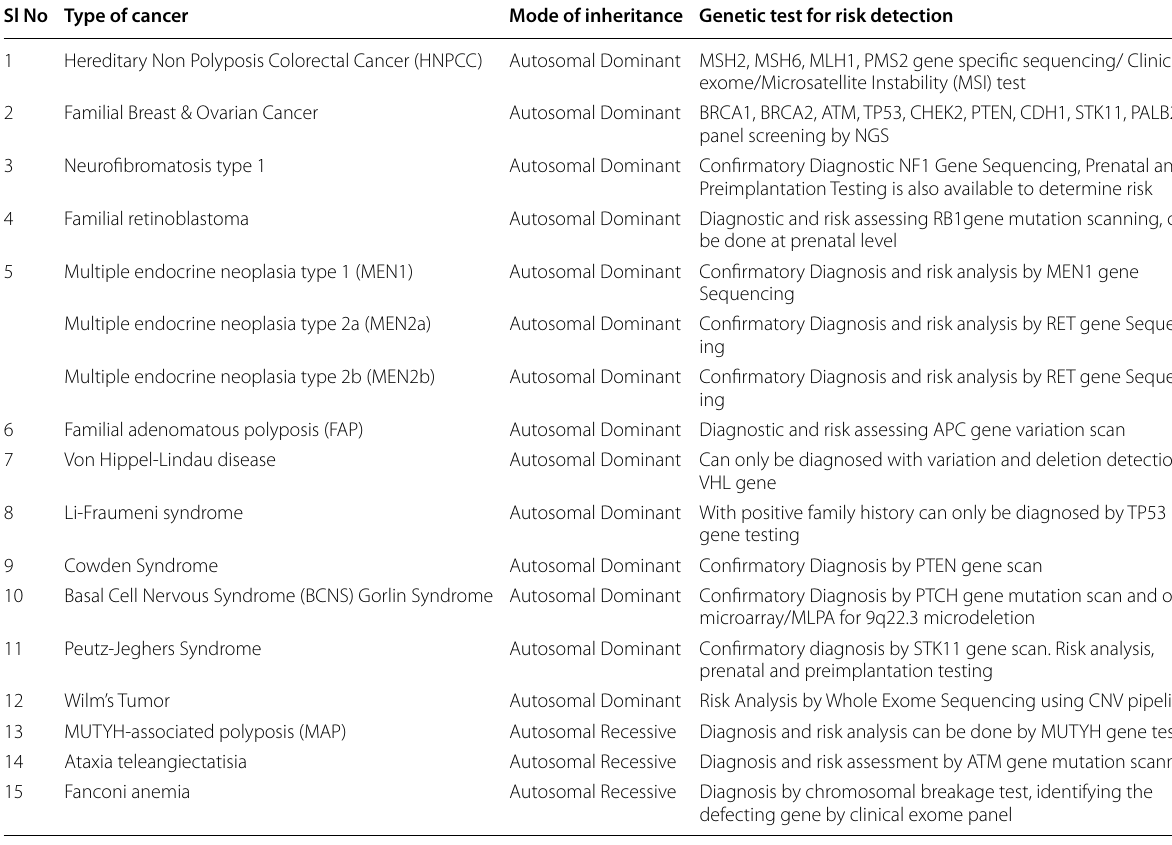
Table 1 Hereditary cancer types and corresponding Genetic tests for their diagnosis Sl No Type of cancer Mode of inheritance Genetic test for risk